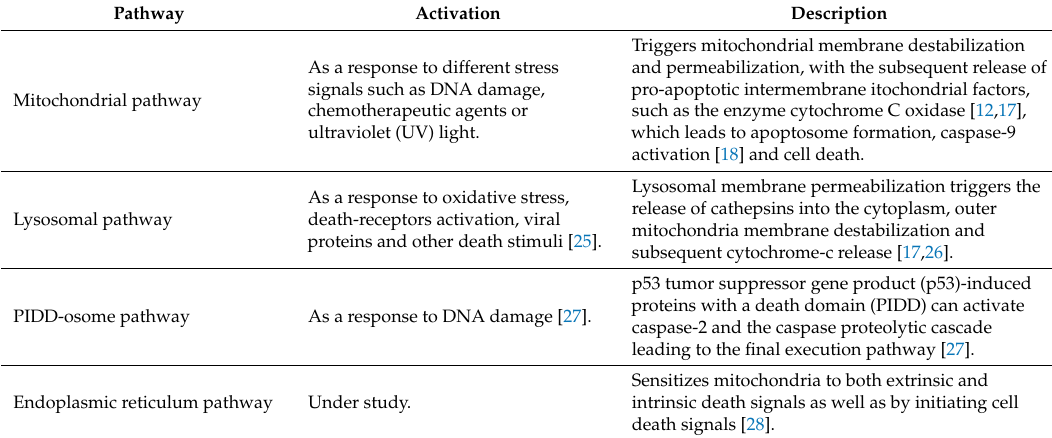
Table 4. Main apoptosis intrinsic